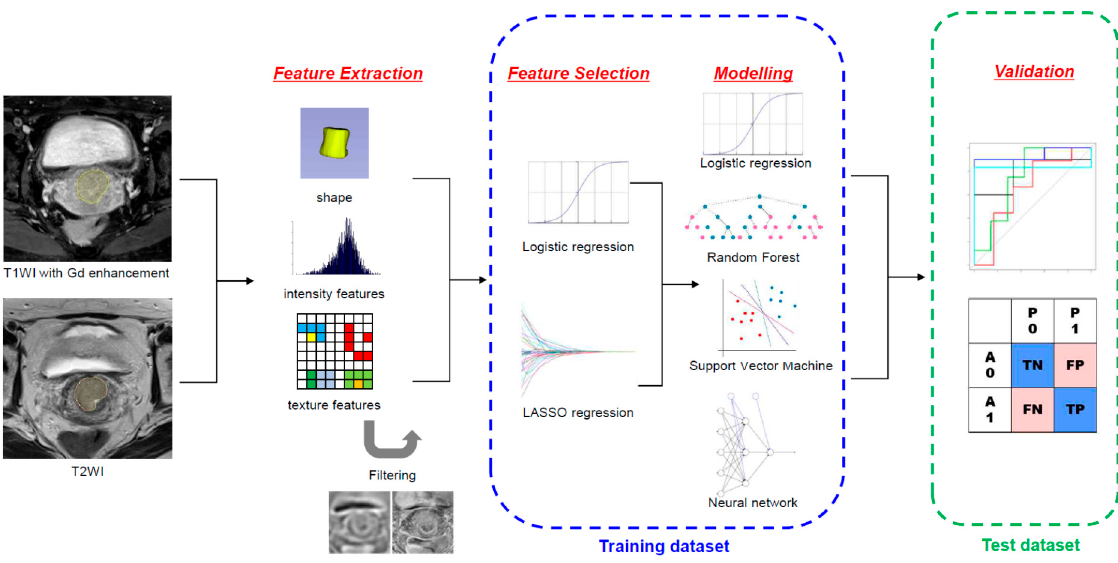
Figure 1. Illustration of the overall process of MRI radiomic analysis to predict tumor budding